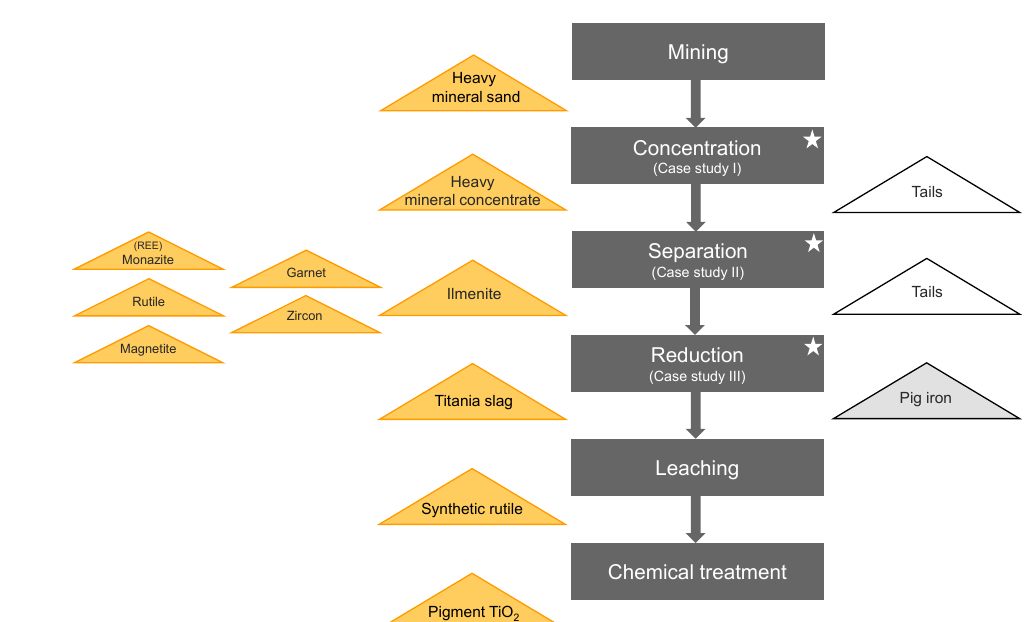
Figure 1. Simplified flowsheet for the process of heavy mineral separation and TiO 2 production. Left triangles = intermediate and final products, middle = process flow, right triangles = by-products or waste. Stars indicate the case studies investigated in this paper.